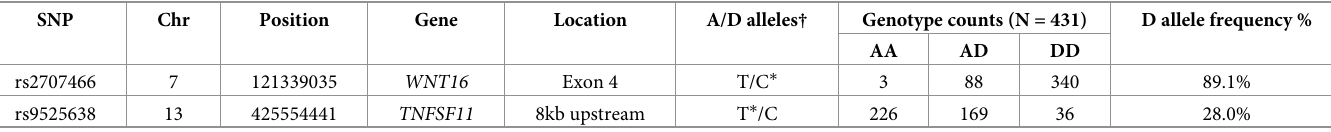
Table 6. Genotype and allele frequencies of the SNPs examined in this study. SNP